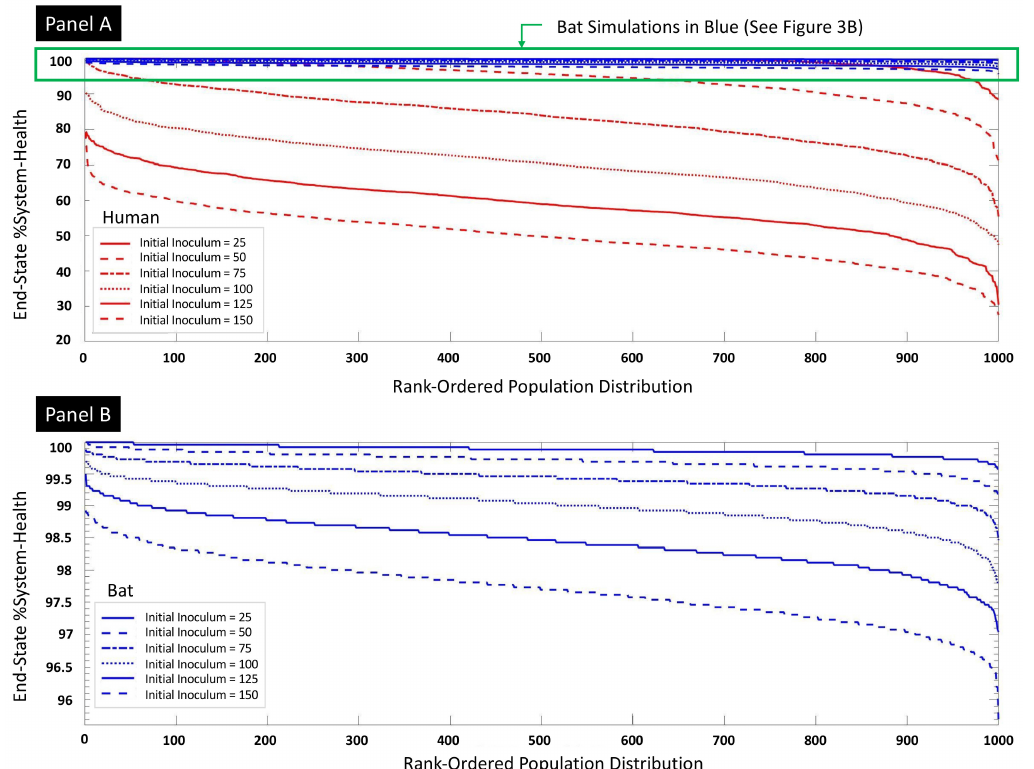
Figure 3. Sweeps of virus initial inoculum for bat and human parameterizations with 1000 stochastic replicates per condition. Panel ( A ) shows both bat (blue)andhuman(red)rank-orderedpopulationdistributionsatinitialinoculumsfrom25to150in25increments. Therank-orderedpopulationdistributions reflect the stochastic replicates ranked by their end #System-Health at the end of 14 days simulated time; while these lines are technically 1000 individual columns, for visualization purposes, they are shown as curves. The decreasing curves seen with increasing initial inoculum are consistent with a dose- dependent worsening of outcomes across a population of runs. Note that the bat parameterizations essentially demonstrate no disease severity (in terms of reduced %System-Health) for the corresponding IIs that generate significantly reduced %System-Health in human parameterizations. Panel ( B ) is a magnification of the results for the bat parameterizations, which shows a similar dose-dependency but with considerably reduced tissue damage (note Y = axis for Panel B starts at